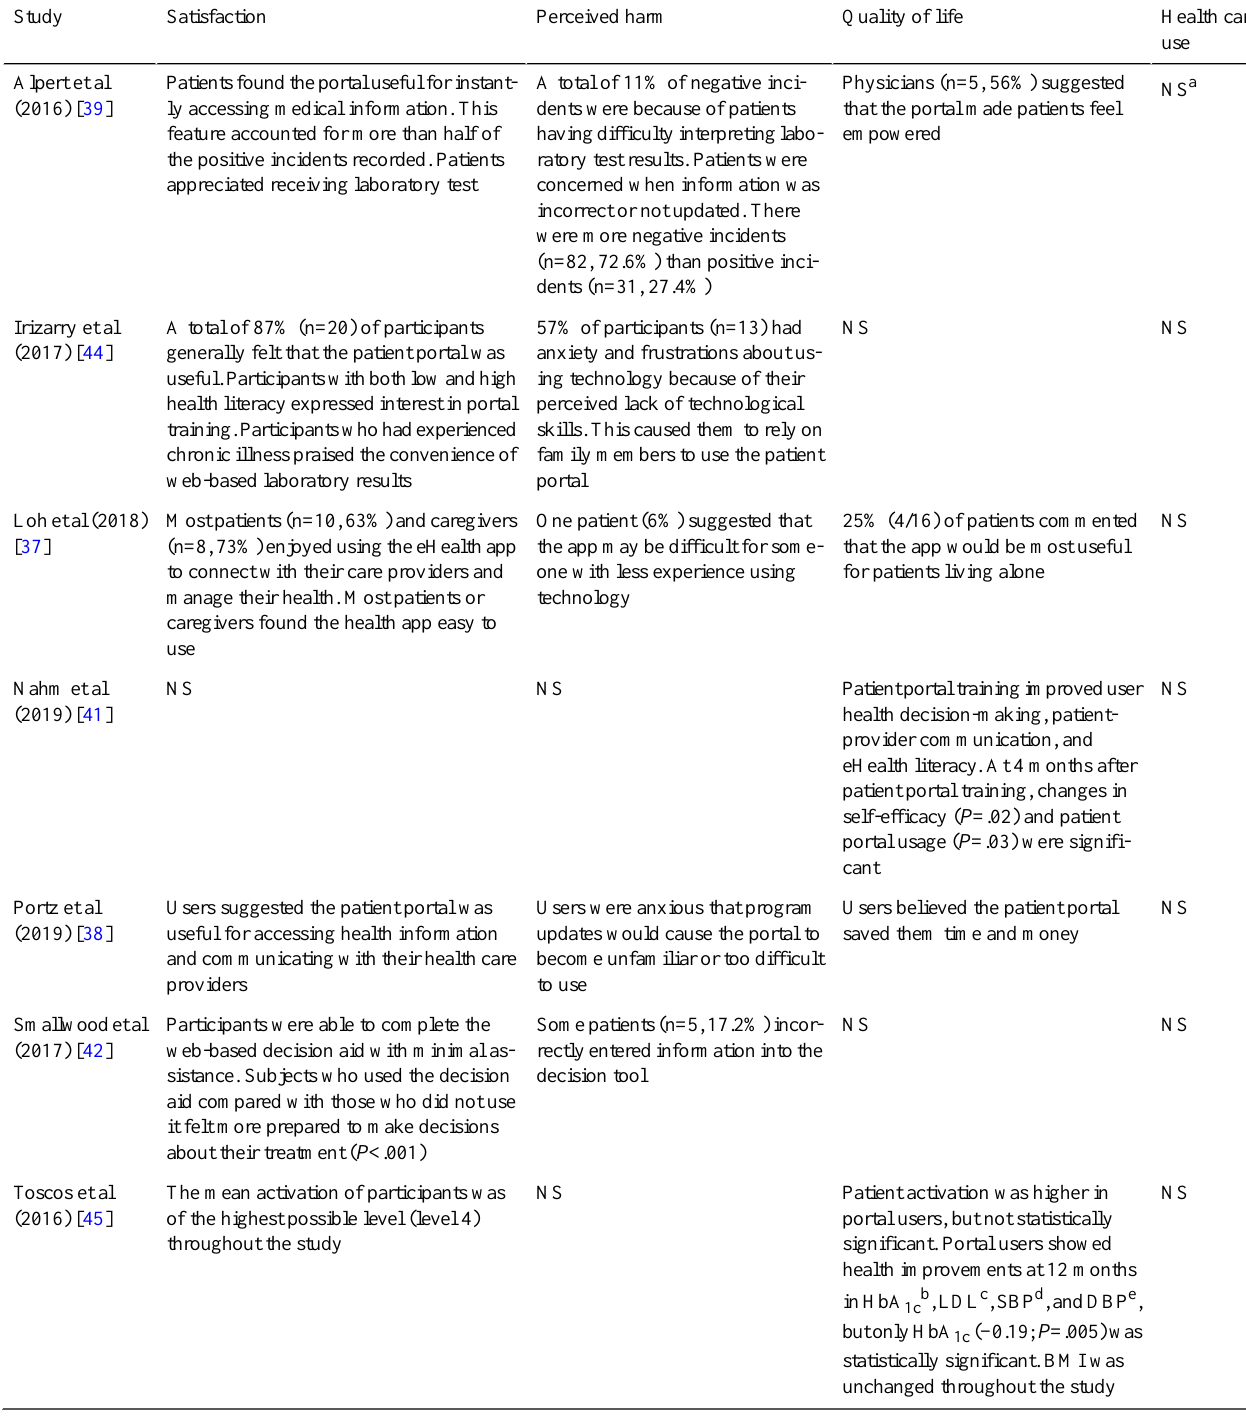
Table 2. Effects of receiving health information in web-based environment for older adults.